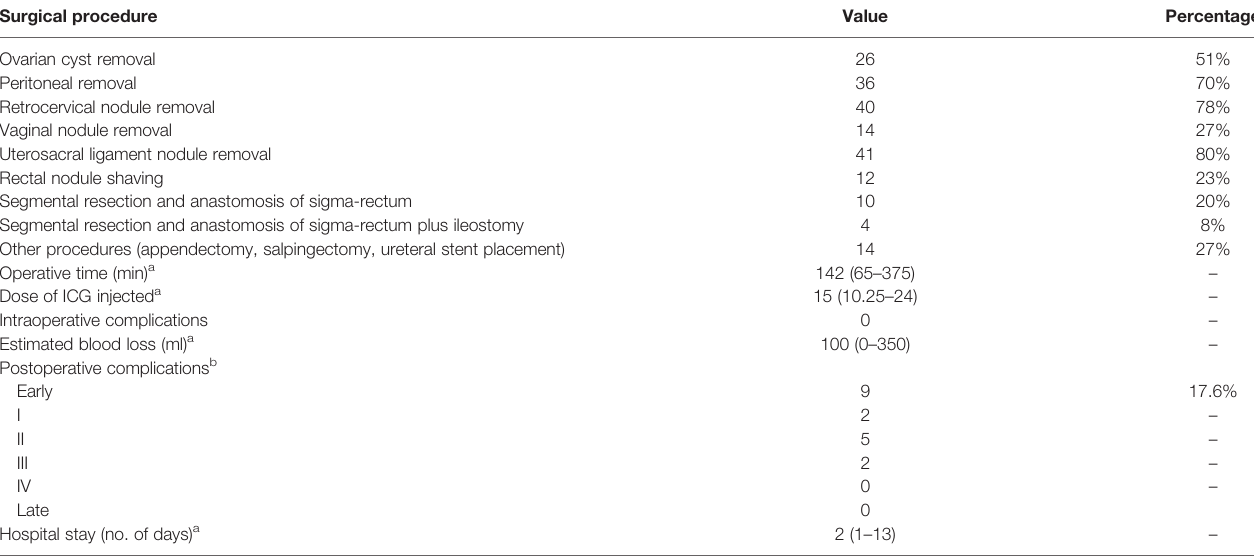
TABLE 2 | Surgical procedures and perioperative